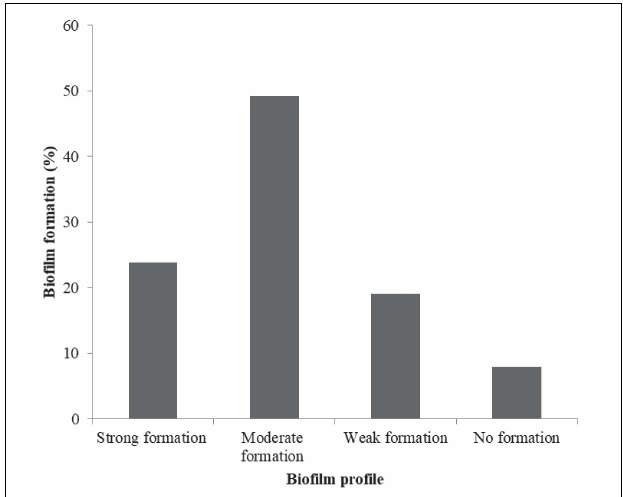
FIGURE 3 | Biofilm formation profile of V. parahaemolyticus from African salads.